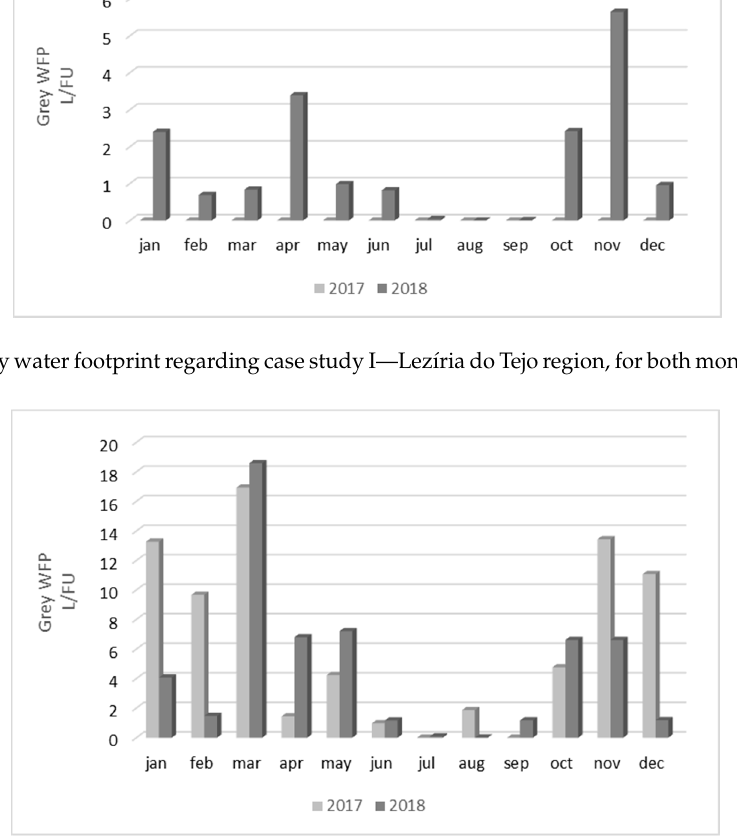
Figure 9. Grey water footprint regarding case study II—Alentejo region, for both monitoring years.